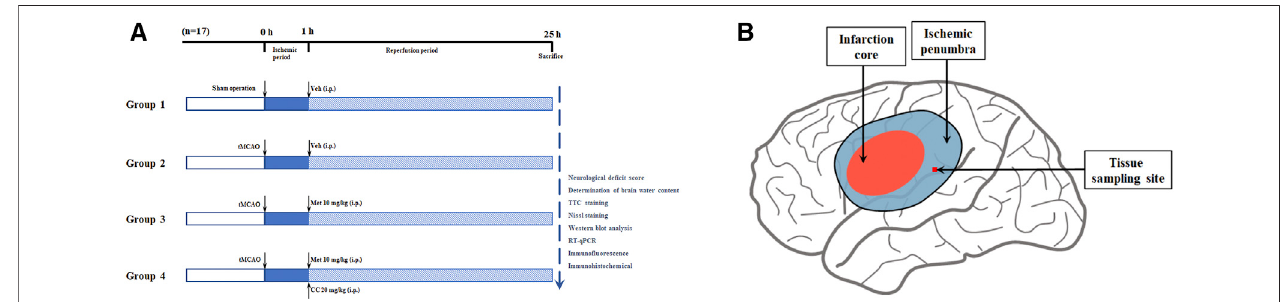
FIGURE 1 | Schematic diagram of animal experiment groupings and ischemic penumbra. (A) The schematic diagram of animal experiment groupings ( n = 17 in each group). Abbreviations:tMCAO,transientmiddlecerebralarteryocclusion;Veh,vehicle;Met,metformin;CC,Compound C. (B) Theschematicdiagram ofischemic